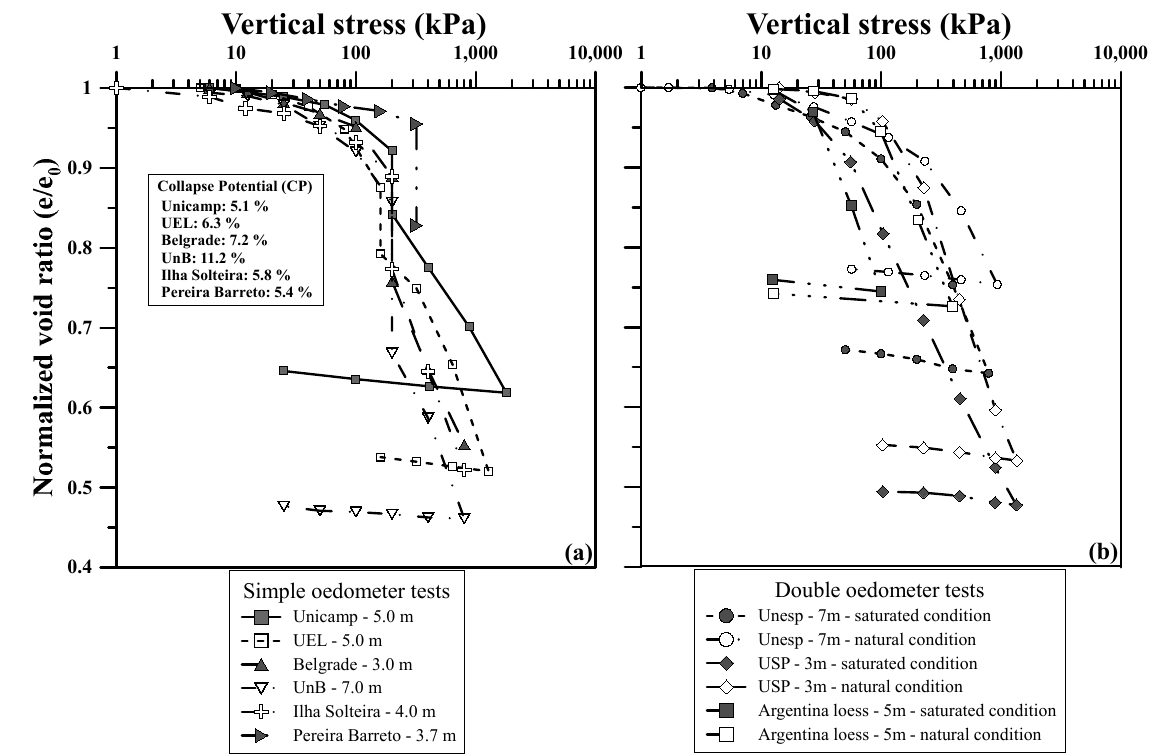
Figure 1. Typical ( a ) single-and ( b ) double-oedometer test data for collapsible soils (adapted from [2,47,48,50,59–63]).